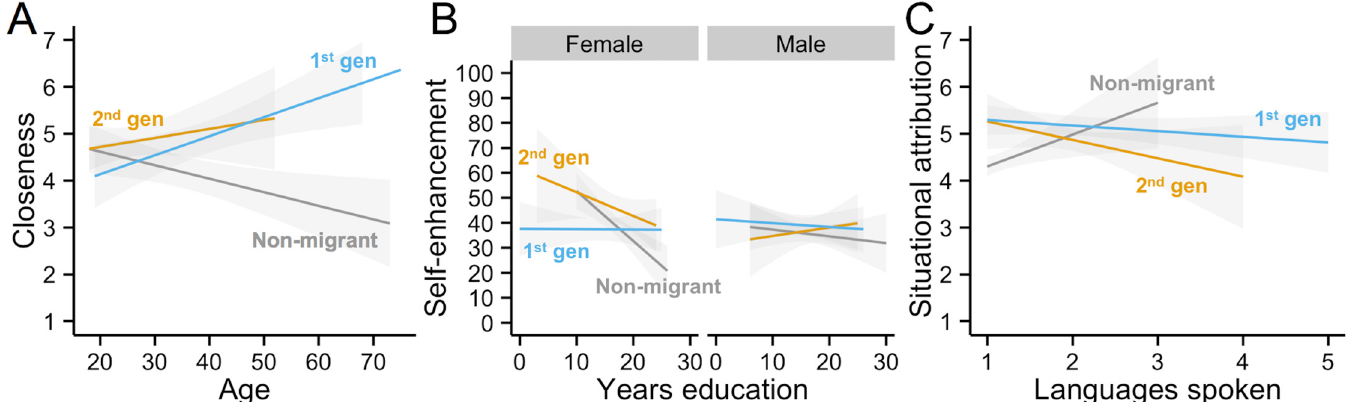
Fig 2. Significant interactions that emerged from the exploratory regression analyses, for (A) closeness, (B) self-enhancement and (C) situational attribution. Shaded areas show conditional